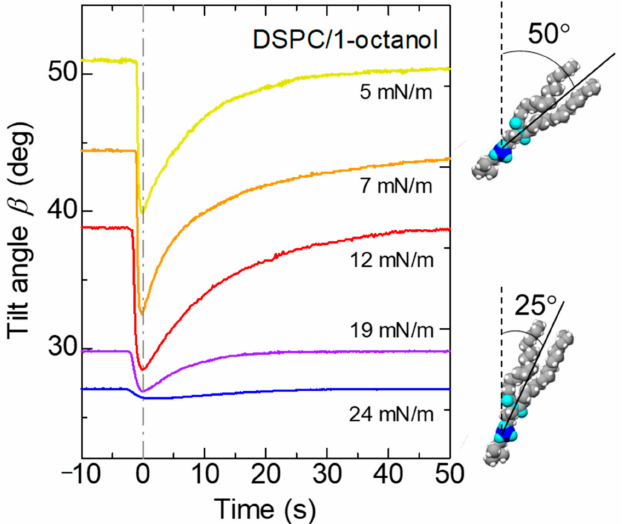
Figure 8. Oscillations of the tilt angle of the hydrophobic chain in DSPC with different initial surface pressure, Π 0 . Yellow: Π 0 = 5 mN/m; Orange: Π 0 = 7 mN/m; Red: Π 0 = 12 mN/m; Purple: Π Π 0 = 19 mN/m; Blue: 0 = 24